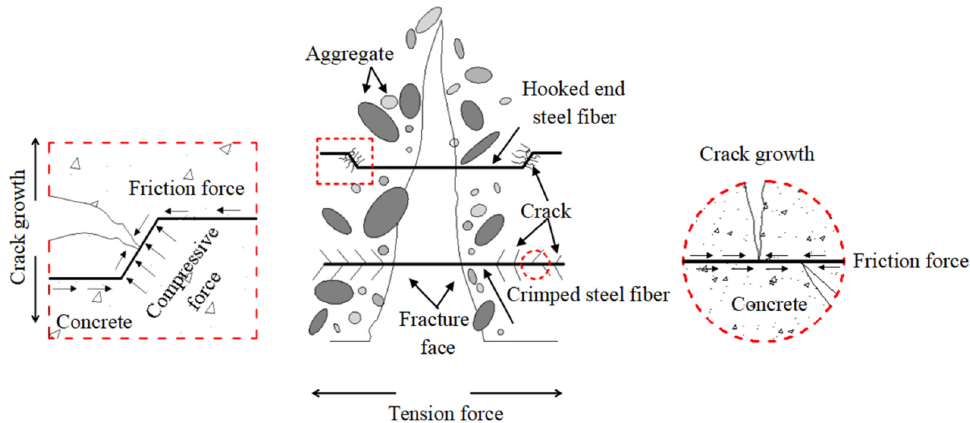
Figure 6. Crack resistance and strengthening model of steel fiber-reinforced